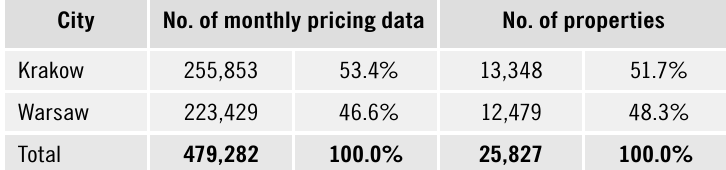
Table 2. The cities and data used in the study City No. of monthly pricing data No. of properties 255,853 53.4% 13,348 51.7% 223,429 46.6% 12,479 48.3% Total 479,282 100.0% 25,827